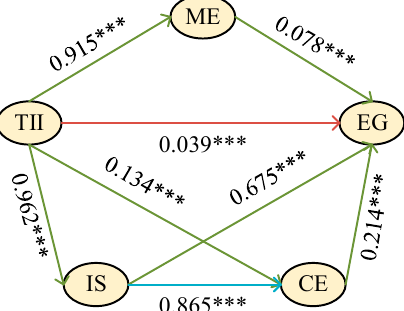
Figure 8. Functional routes of TII on EG. Notes: *** Significant at 1% level.